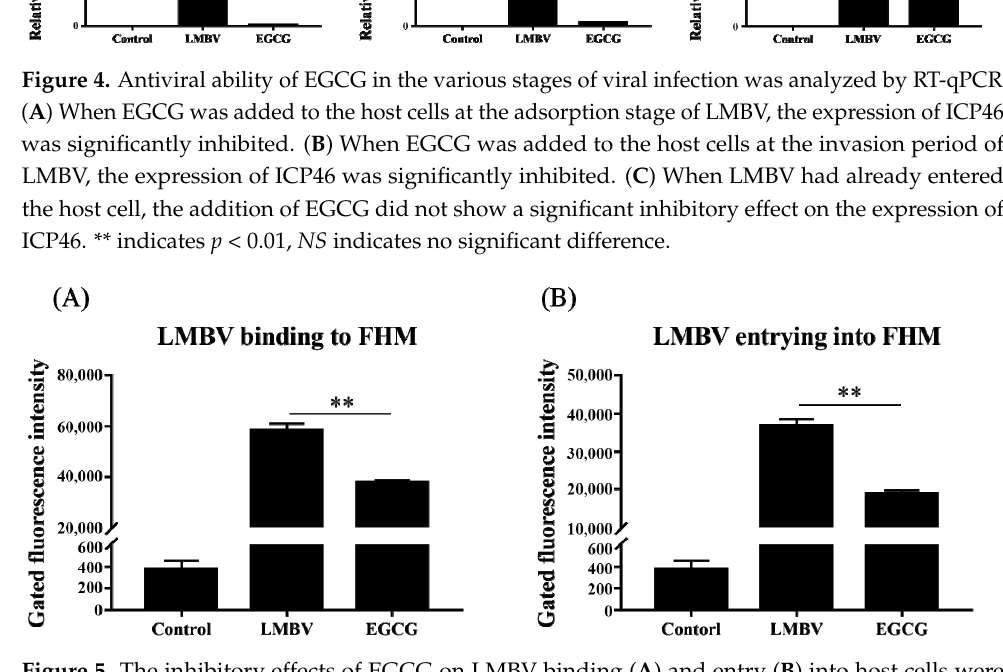
Figure 5. The inhibitory effects of EGCG on LMBV binding ( A ) and entry ( B ) into host cells were illustrated by flow cytometry analysis. Cy5-fluorescence signals were significantly decreased in EGCG-treated cells compared with the control group. ** indicates p < 0.01.